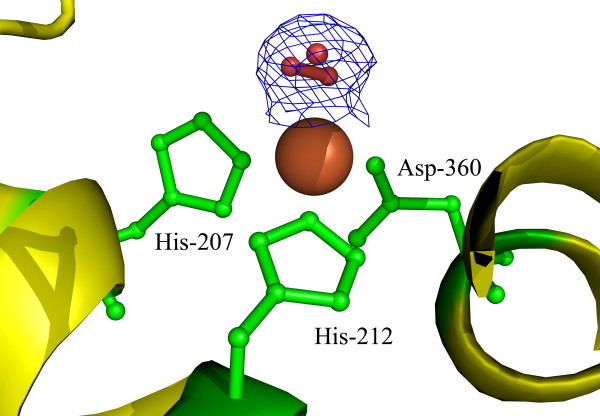
Mononuclear iron bound to oxygen and water. Active site of BPDO-OB1 showing the dioxygen molecule and water molecule modeled. The dioxygen molecule is shown as a ball and stick molecule, while a sphere represents the water molecule. The mesh is 1.0 σ 2Fo-Fc electron density.